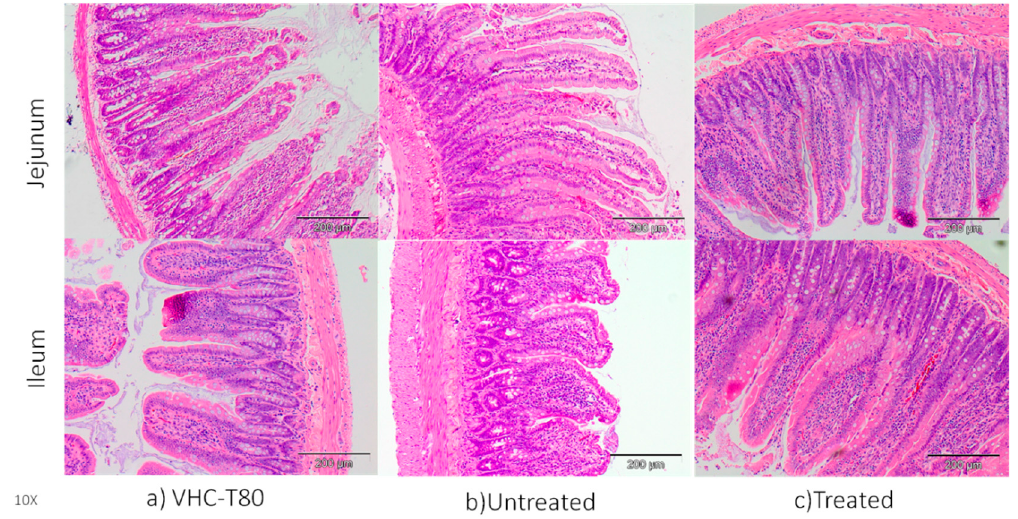
Figure 9. Representative diagram of H&E staining (10 × magnification) of ileum and jejunum collected from rats ( a ) VHC (Tween 80) ( b ) Untreated ( c ) Treated BPA water and BPA water ( n = 3–5).